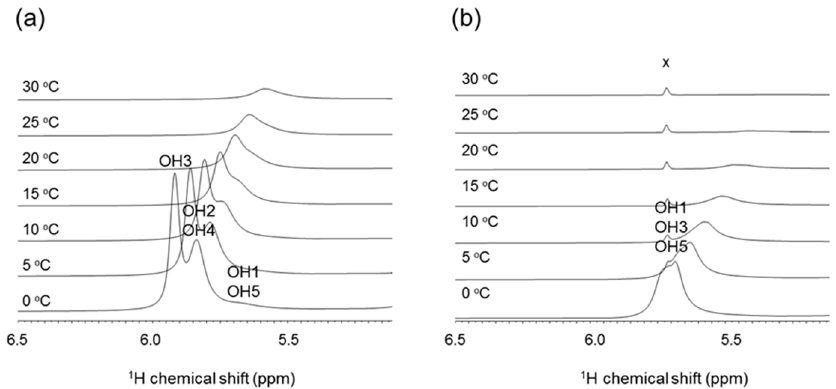
Figure 5. Part of 1D- 1 H-NMR (OH region) spectra of ribitol and 1,3,5-pentanol measured at 0, 5, 10, 15, 20, 25, and 30 ◦ C in 10 mM sodium acetate buffer, pH 6.0 (H 2 O:D 2 O = 1:1). ( a ) Ribitol. ( b ) 1,3,5-Pentanol. x = impurity.